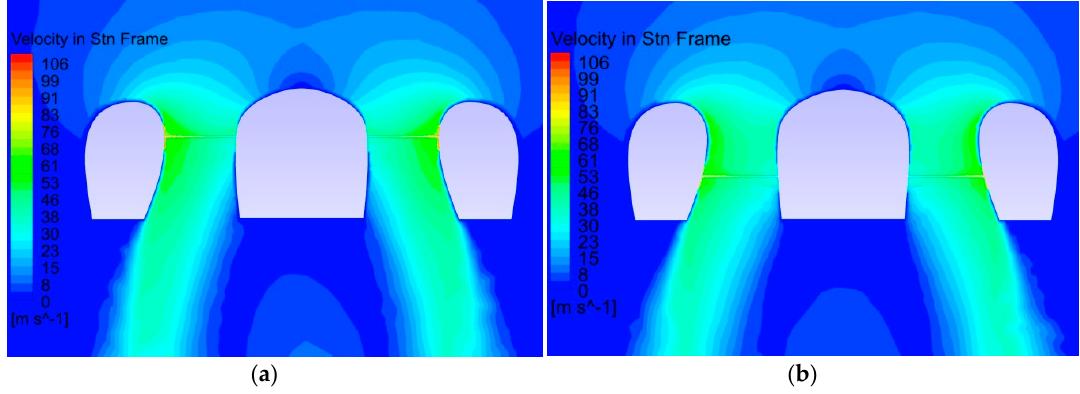
Figure 9. Velocity contour in the central plane of aircraft. ( a ) Fan at the throat; ( b ) Fan at the diffuser. Table 3. The comparison of the location of the fan.